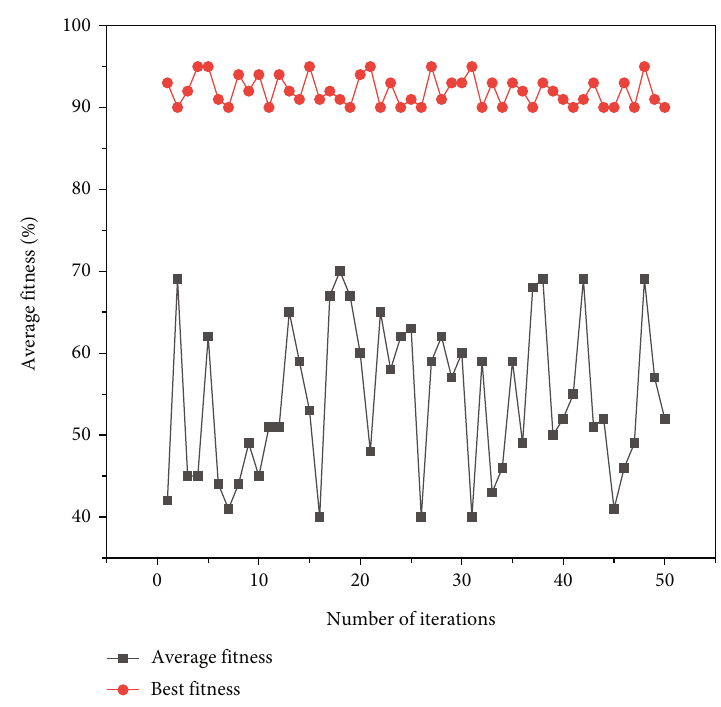
Figure 3: PSO-SVM parameter search process in the time